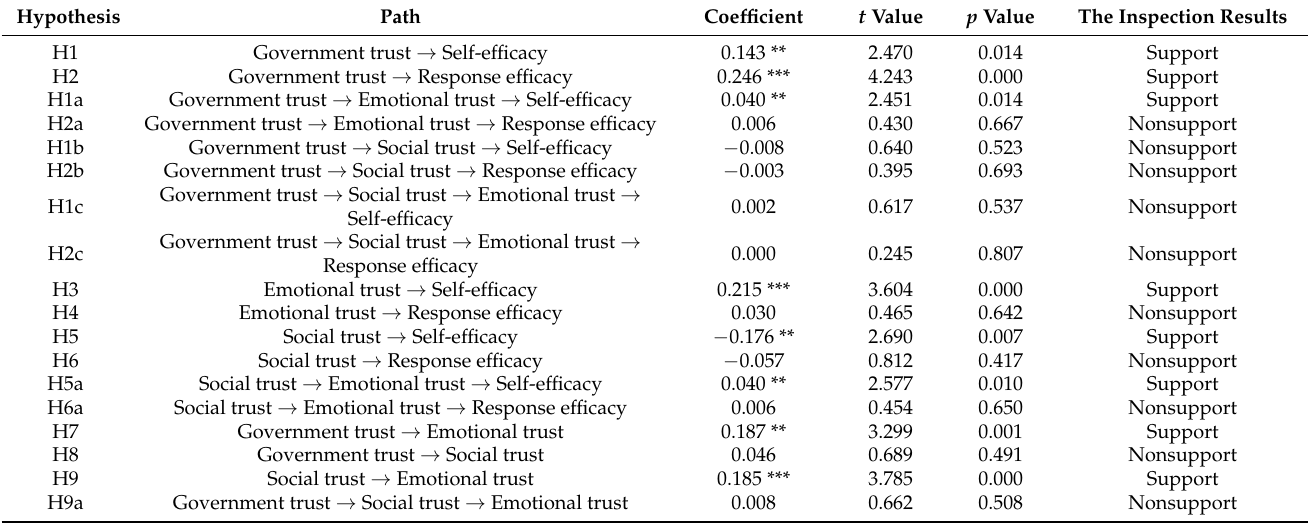
Table 6. Description of model hypothesis test